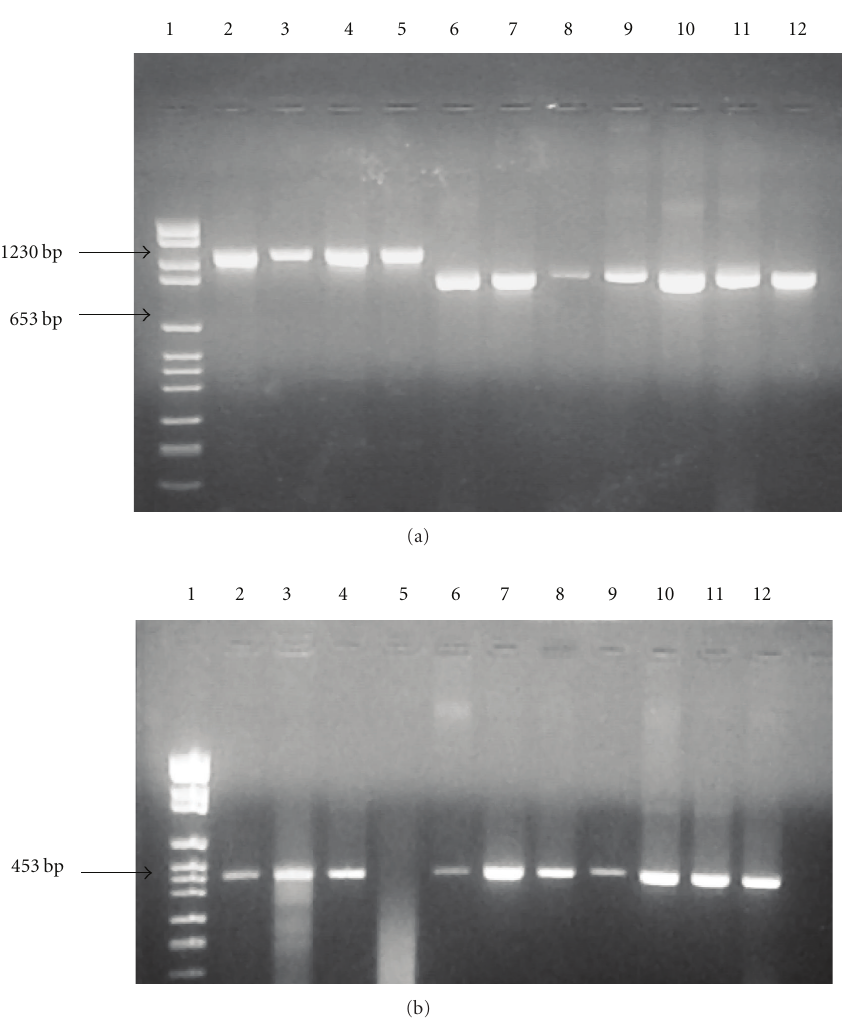
Figure 1: PCR amplicons of the (a) 16S rRNA gene of H. fennelliae (lanes 2–5) and other Helicobacter strains (lane 6: H. cinaedi , lanes 7-8: H. pylori , lane 9: H. mesocricetorum , lane 10: H. pametensis , lane 11: H. cholecystus, and lane 12: H. canadensis ) and (b) rpoB gene of H. fennelliae (lanes 5–9) and other Helicobacter species (lane 2: H. pylori , lane 3: H. cinaedi , lane 4: H. canadensis , lane 10: H. pullorum , lane 11: H. mustelae , and lane 12: H. cholecystus